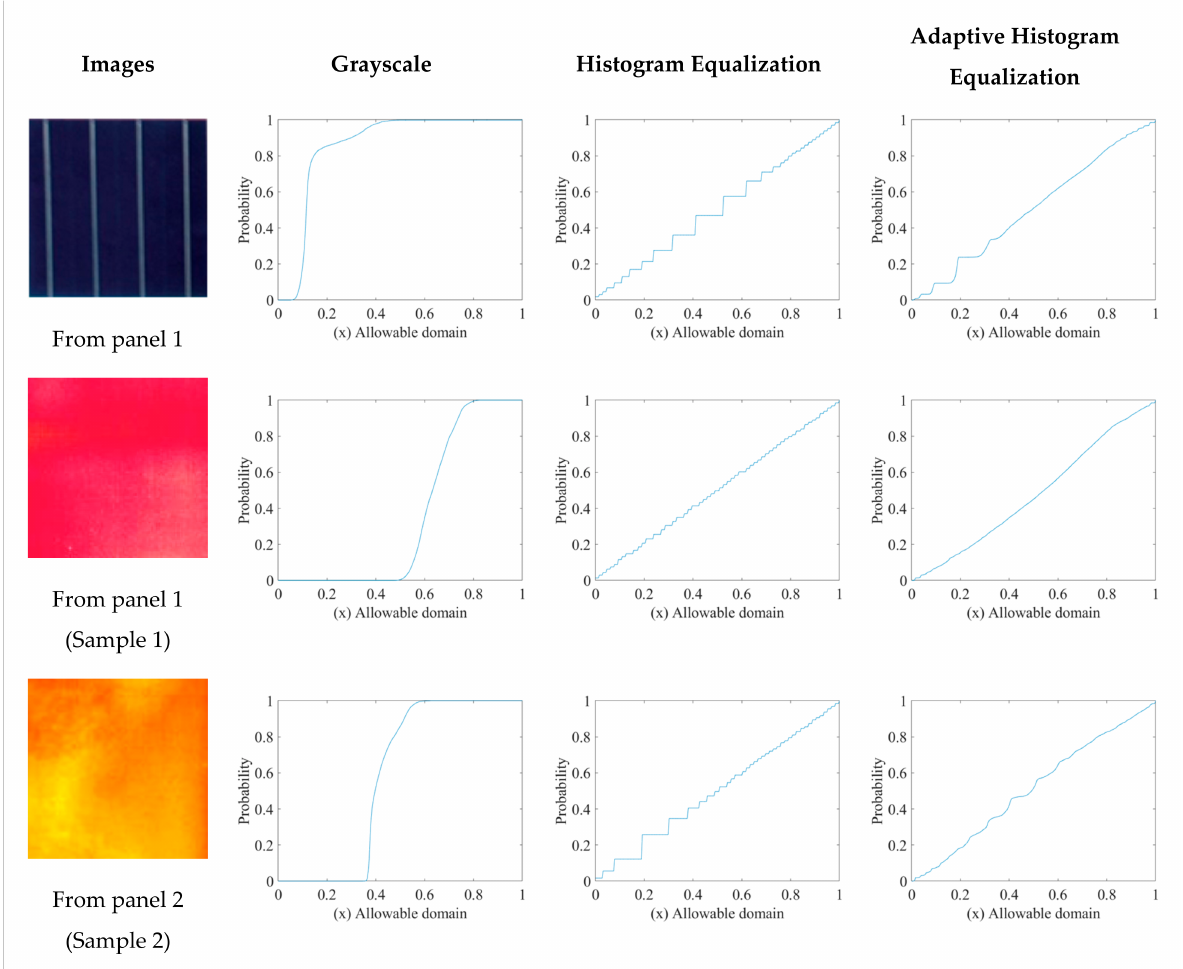
Figure 16. The CDF comparison on the three images under three